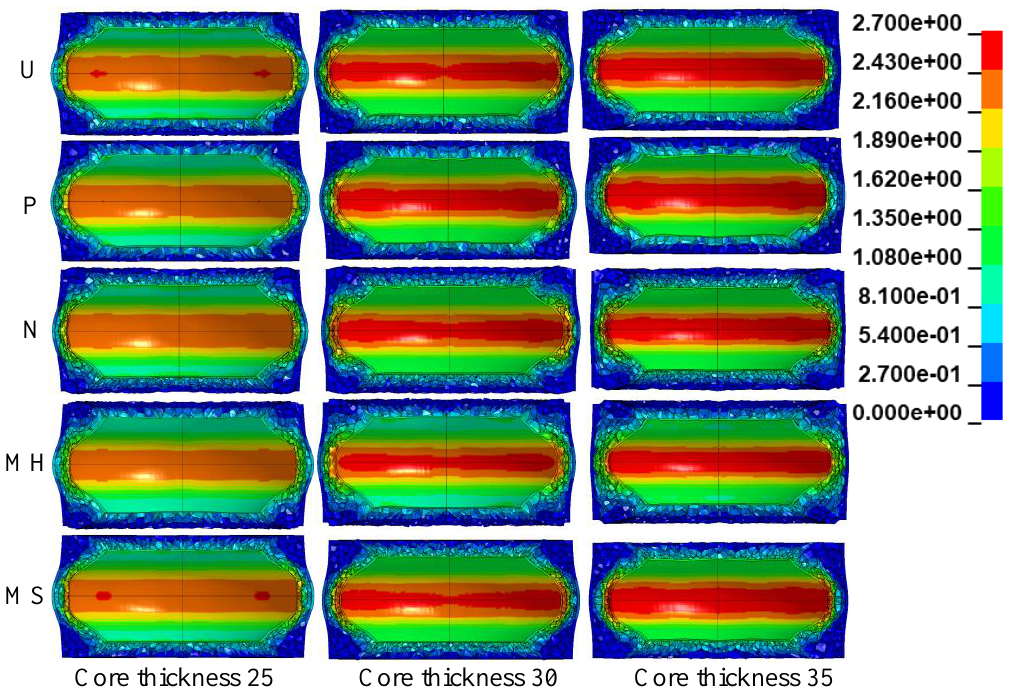
18 of 24 Figure 19. Specific energy absorption of foam core under different core density gradients. 3.4. Influence of the Core Thickness When the inner tube size was fixed and the core density gradient was 1.0, as the core